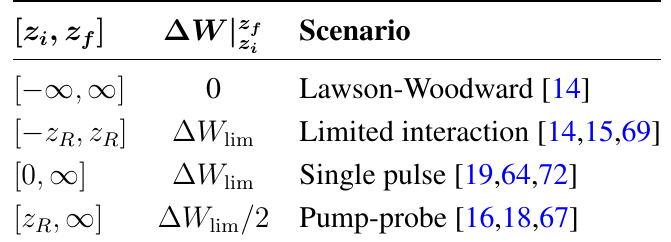
Table 2. Comparison between different electron acceleration scenarios in RPLBs. In the first column is the interaction range, followed by the corresponding change in energy calculated with Equation (11b), and finally a short description (scenario) with